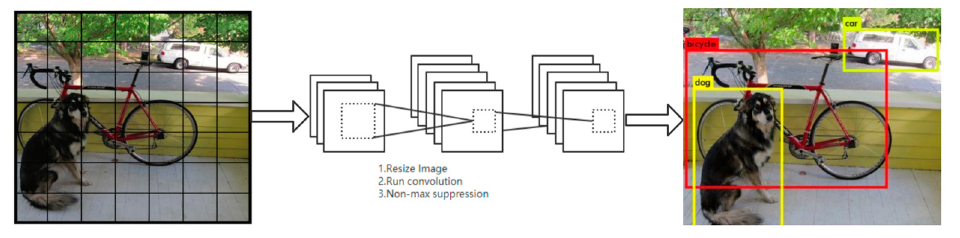
Figure 1. Schematic diagram of YOLO target detection.